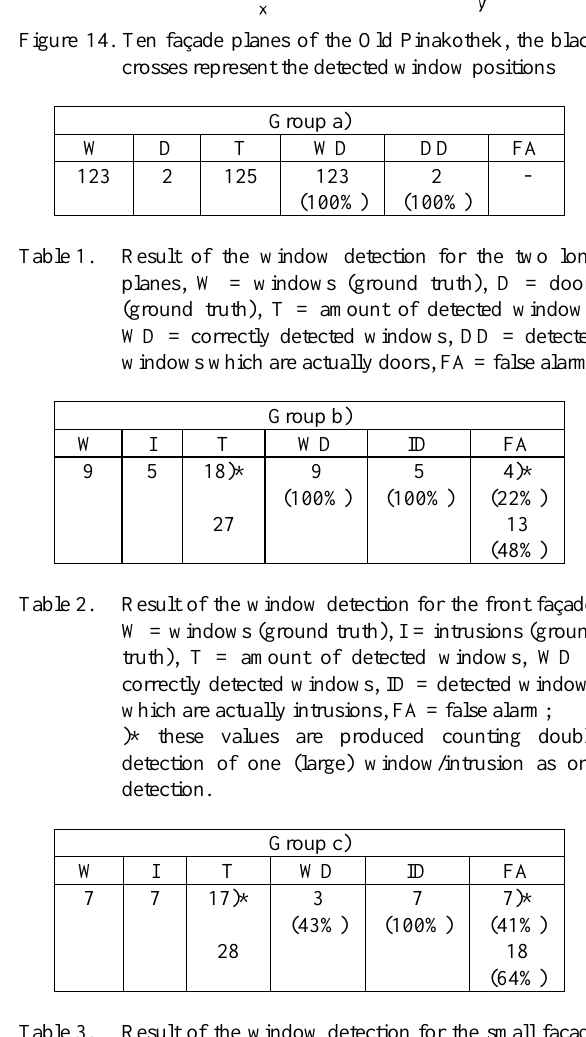
Figure 10. Points derived with a bounding box which delimits the points to the area of 5 m before and behind the façade (northern façade of the Old Pinakothek).